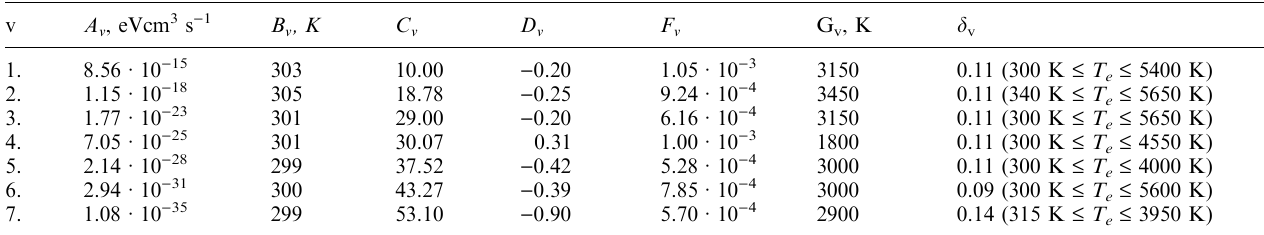
Table 1. Coe(cid:129)cients for calculations of Q v A , eVcm 3 s ) 1 B v